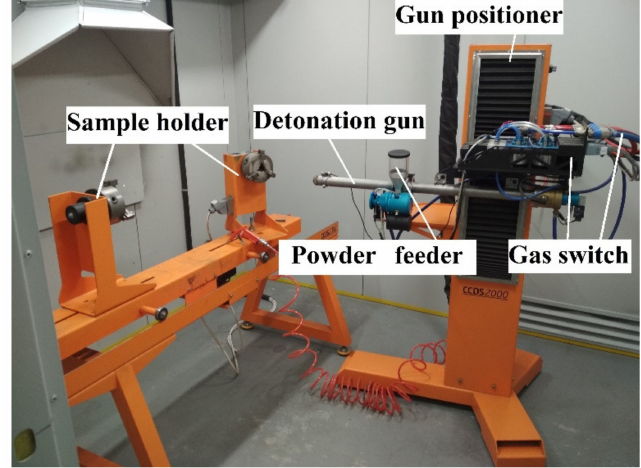
Figure 3. Overview of detonation spray equipment